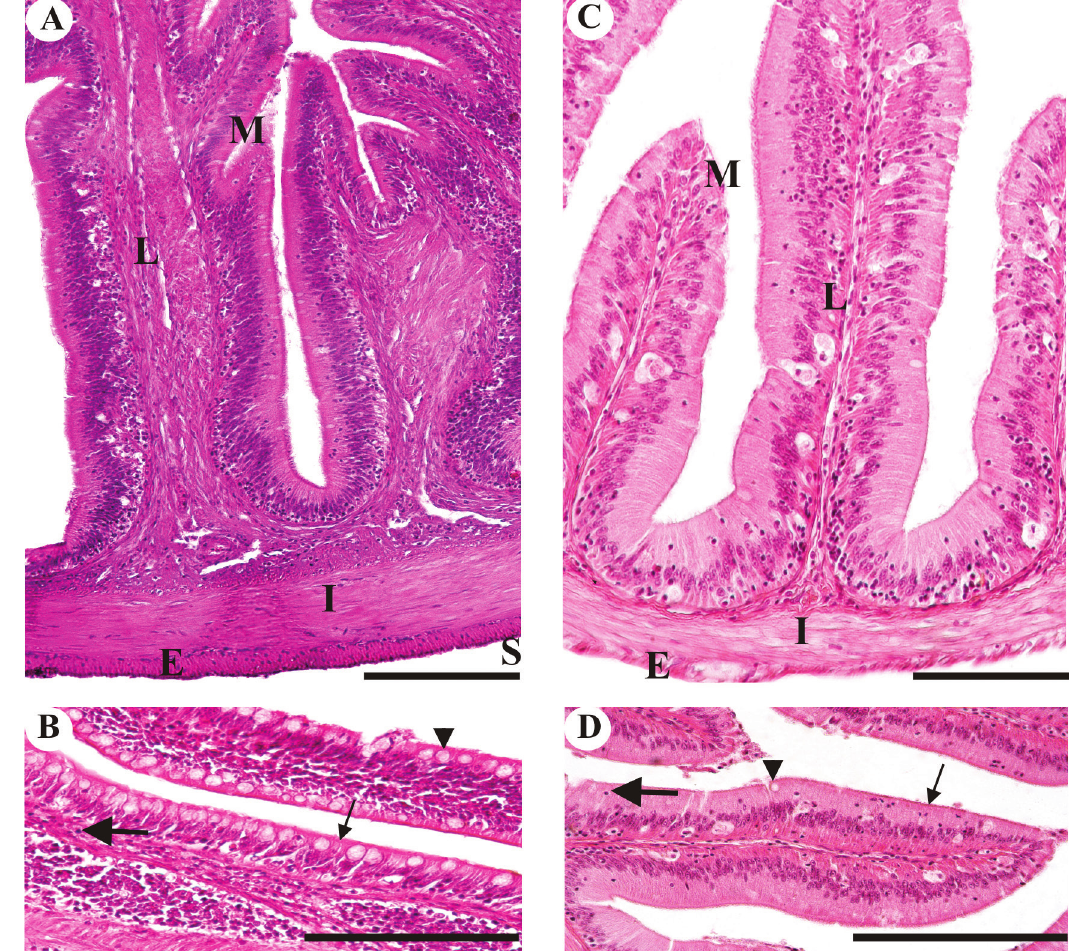
Fig. 3 - Histological organization of the intestine and pyloric caeca: (A). Cross-section of the intestine showing the mucosa (M), lamina propria (L), internal muscular layer (I), external muscular layer (E), serosa (S), HE (bar = 200 μm). (B). Detail of the mucosa (M) showing goblet cell (arrowhead), lymphocyte (thick arrow), brush border (thin arrow), HE (bar = 100 μm). (C). Cross section of pyloric caeca showing mucosa layer (M), lamina propria (L), internal muscular layer (I), external muscular layer (E), HE (bar = 200 μm). (D). Mucosa layer of the pyloric caeca showing goblet cell (arrowhead), lymphocyte (thick arrow), brush border (thin arrow), HE (bar = 100